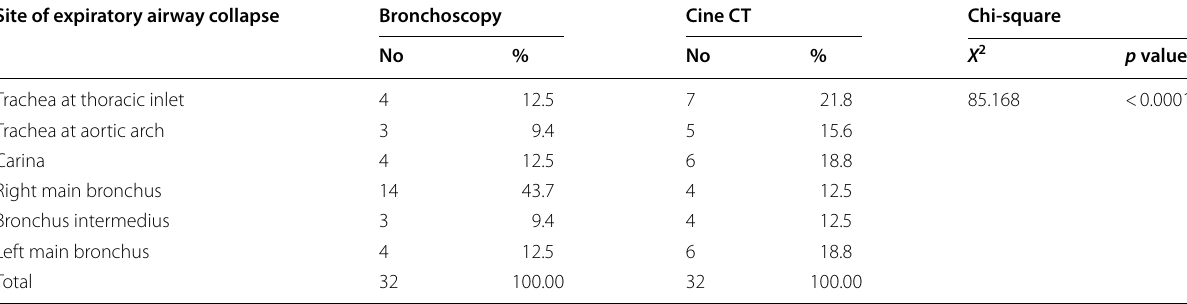
Table 1 Sites of expiratory airway collapse detected by cine CT compared to bronchoscopy